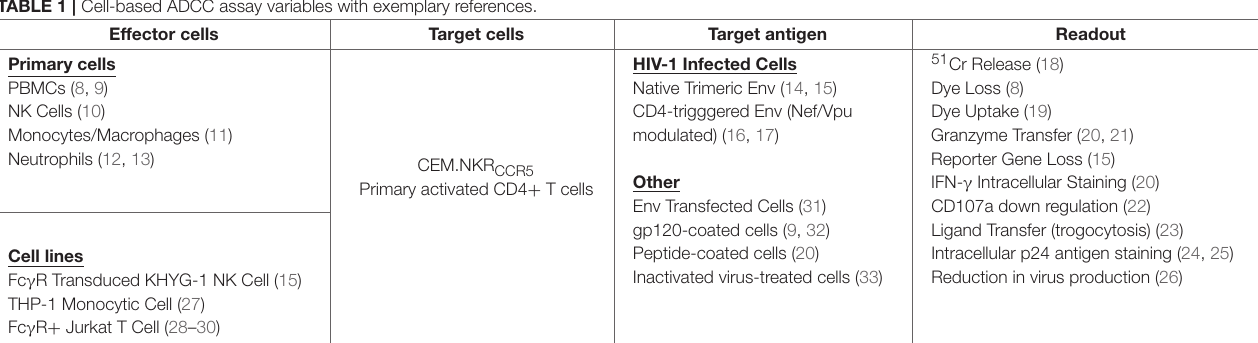
TABLE 1 | Cell-based ADCC assay variables with exemplary